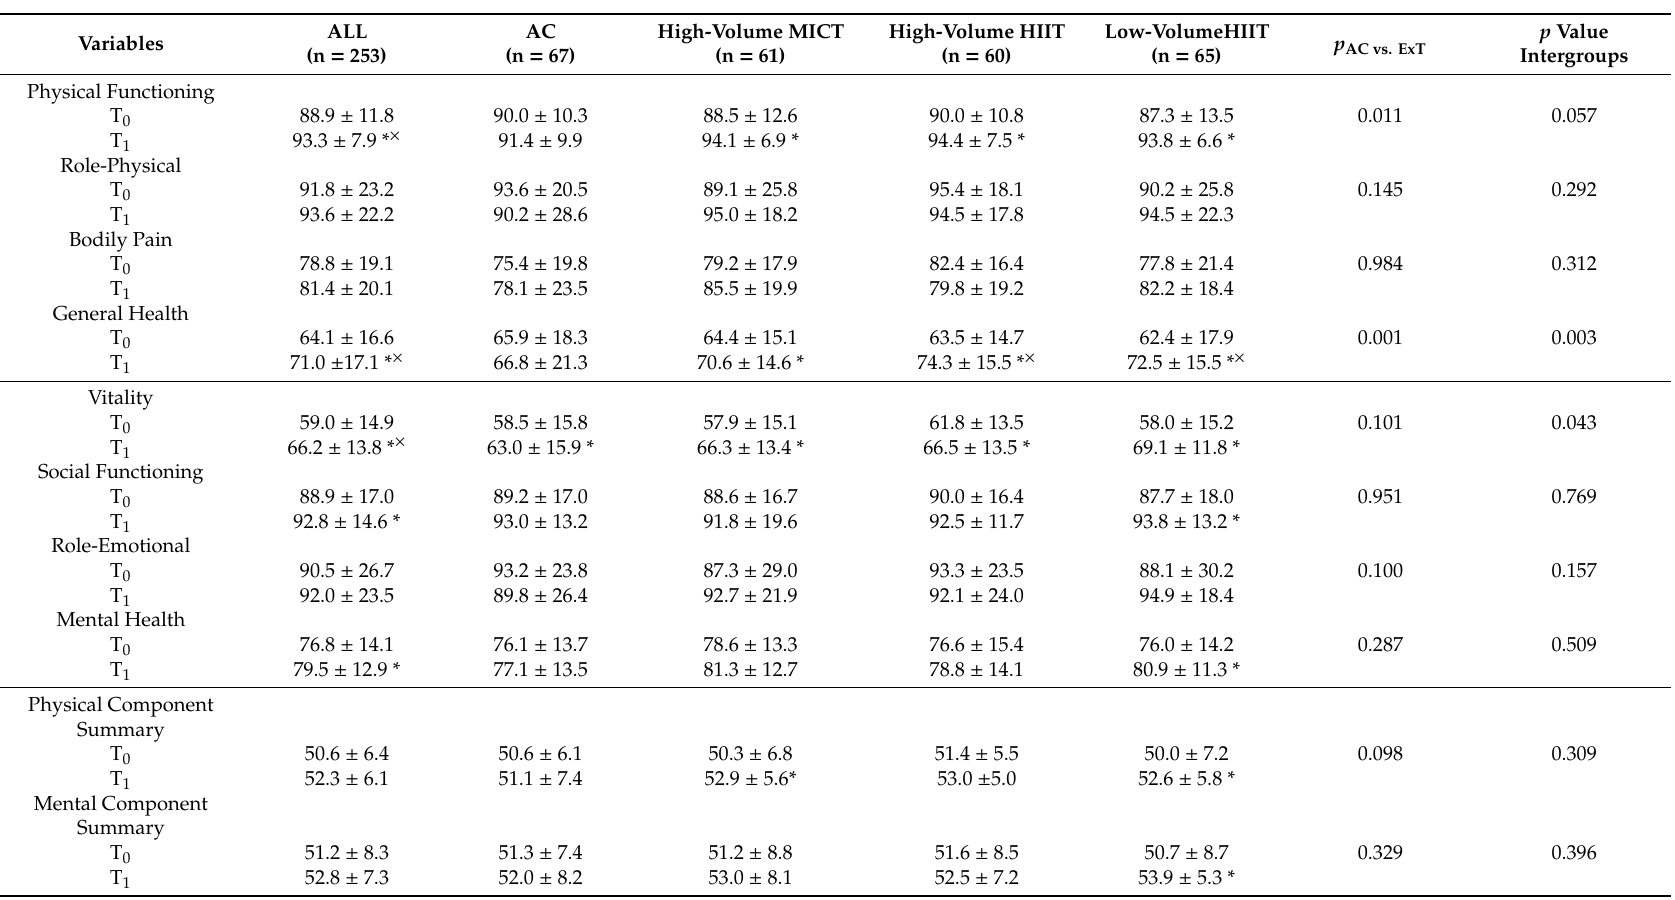
Table 2. Health-related Quality of Life outcomes before and after a 16-week intervention program in the EXERDIET-HTA